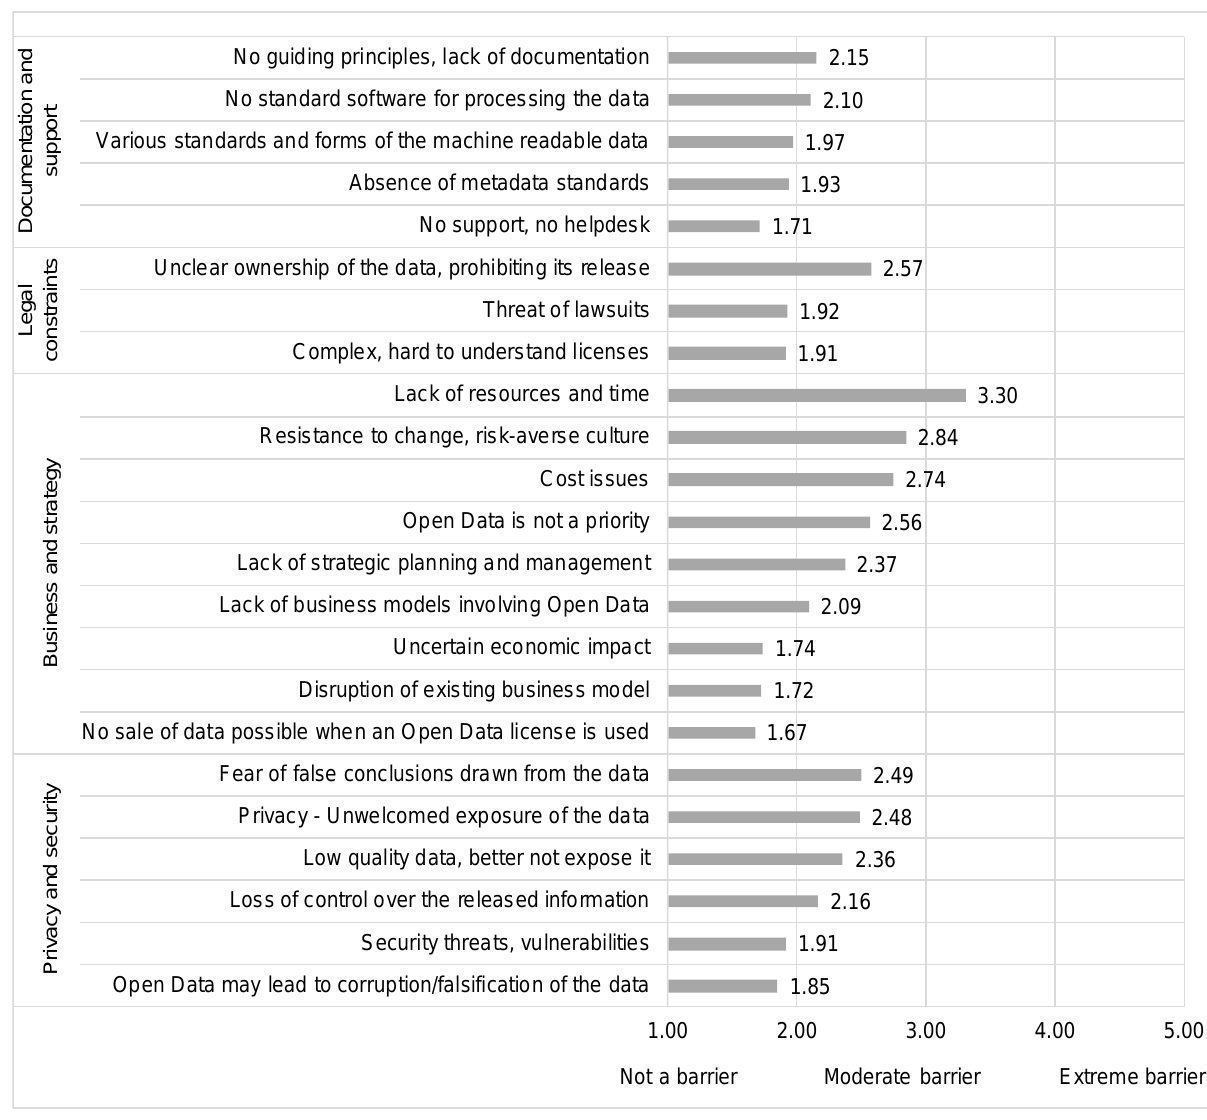
Figure 6: Barriers to Opening Open Data (Source: